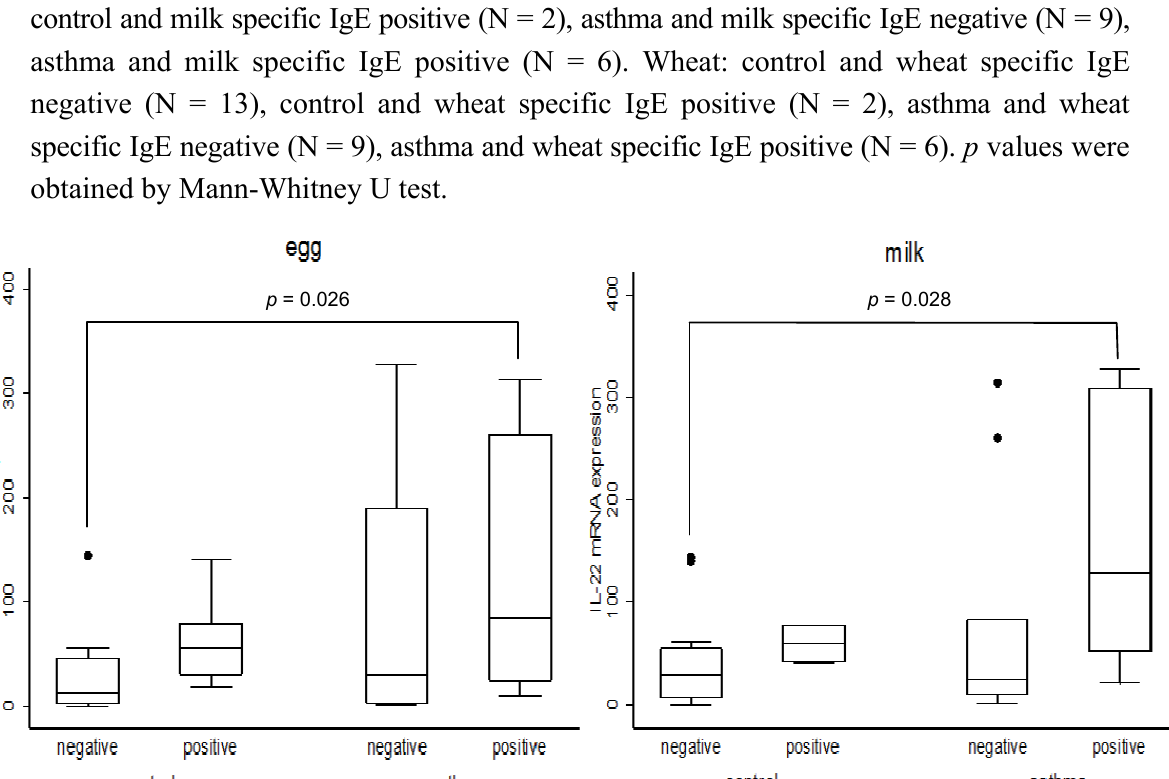
Figure 1. Association between IL22 and allergen specific IgE. Numbers of each category subject are as follows. Egg: control and egg specific IgE negative (N = 8), control and egg specific IgE positive (N = 7), asthma and egg specific IgE negative (N = 4), asthma and egg specific IgE positive (N = 11). Milk: control and milk specific IgE negative (N = 13), control and milk specific IgE positive (N = 2), asthma and milk specific IgE negative (N = 9), asthma and milk specific IgE positive (N = 6). Wheat: control and wheat specific IgE negative (N = 13), control and wheat specific IgE positive (N = 2), asthma and wheat specific IgE negative (N = 9), asthma and wheat specific IgE positive (N = 6). p values were obtained by Mann-Whitney U test.